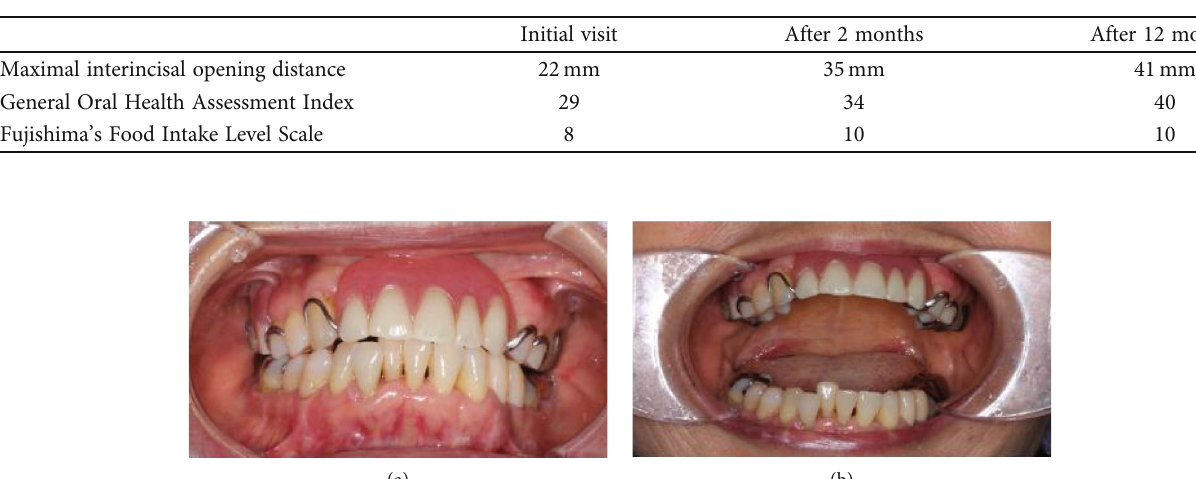
Table 1: Measurements before and after mouth-opening training.